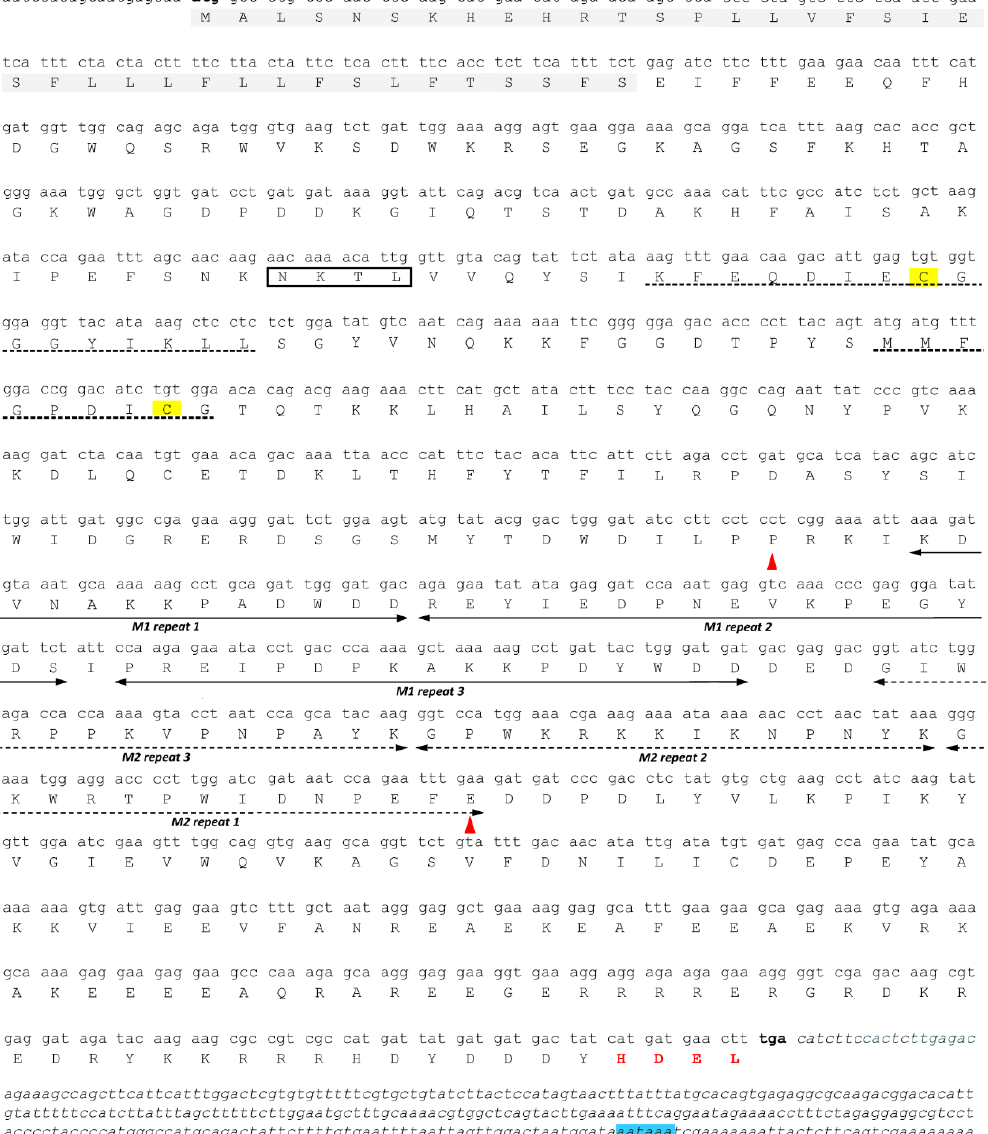
Figure 2. Nucleotide sequence of the full-length Petunia hybrida calreticulin 3a ( PhCRT3a) cDNA and its predicted amino acid sequence. The predicted signal peptide in the N-domain is highlighted in grey, and the predicted N -glycosylation site is boxed. CRT family signature motifs 1 and 2 are shown by dotted lines. The triplicate repeats M1 [PXXIXDP(E/D)(A/D)XKP(E/D)DWD(D/E)] and M2 [GXWXXPXIXNPXYX] are marked with two-headed solid and two-headed dotted arrows, respectively. The cysteine residues are marked with yellow. The proline-rich P-domain is enclosed by the two red arrowheads. The ER-retention motif (HDEL) is indicated in red font in the C-terminal domain, while blue highlighting marks the polyadenylation signal. Nucleotide sequences of the 5 (cid:48) and 3 (cid:48) UTRs are in italics, while the start and stop codons are indicated in